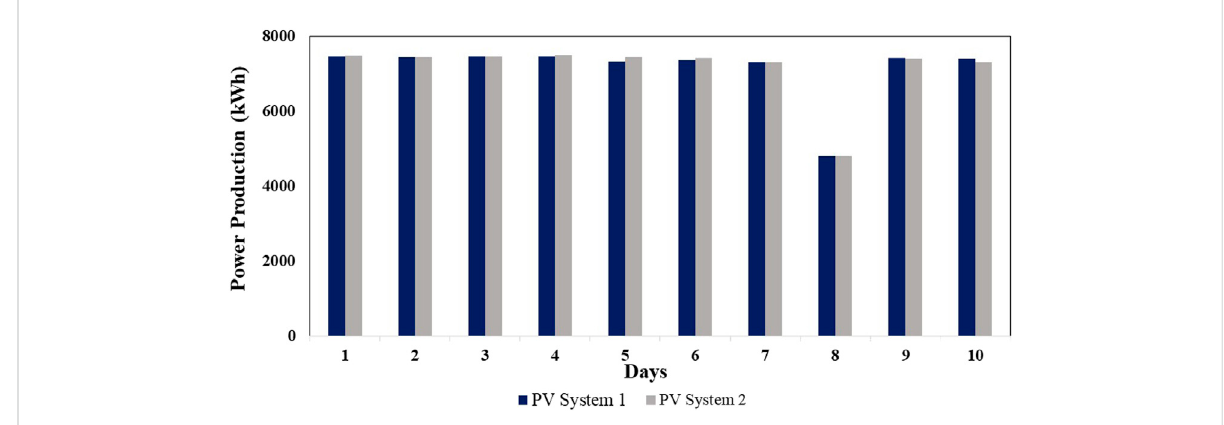
FIGURE 9 Comparison of cleaned PV systems.